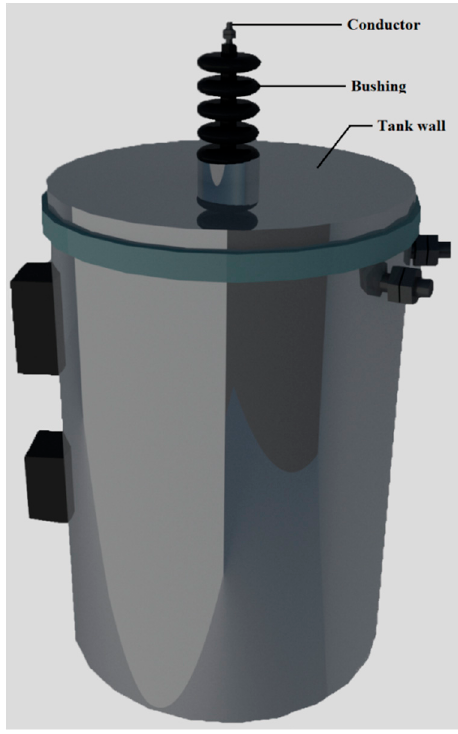
Figure 1. Conductor passing through the bushing regions of a transformer.